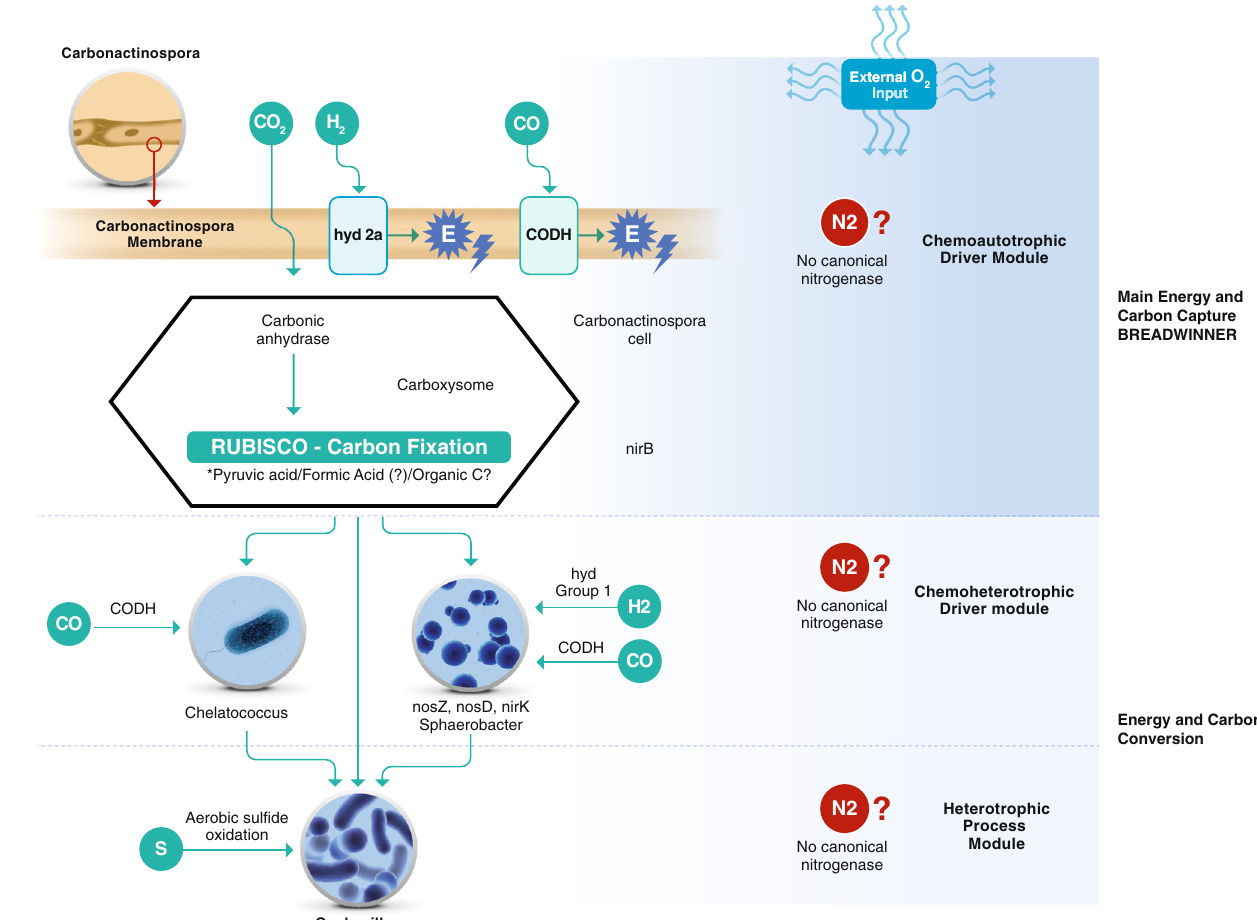
Fig. 6 Proposed metabolic pathways that drive the carbonitro fl ex consortium interactions. Main energy and carbon capture are provided by Carbonactinospora thermoautotrophica StC (the breadwinner and sole member capable of carbon fi xation), whereas the fi xed carbon integrated into the consortium is used by Sphaerobacter thermophilus , Chelatococcus spp., and Geobacillus